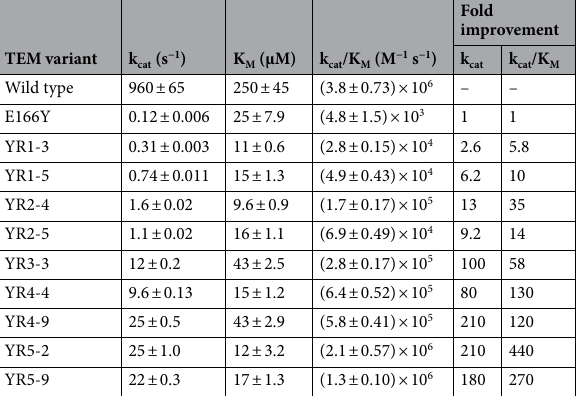
by Mfold 26 (Fig. 2c). The more relaxed regulation of TEM expression in XL1-Blue/pAT- cr3 -TEM was likely to derive from the shortened hairpin structure of cr3 (ΔG cr3 = − 32.90 kcal/mol). Western blot was performed to further examine the levels of wild-type TEM expression in pAT-TEM and pAT- cr3 -TEM. XL1-Blue/pAT-TEM and XL1-Blue/pAT- cr3 -TEM were grown to mid-log phase and induced with different aTc concentrations. The result showed that, in XL1-Blue/pAT-TEM, 25 nM aTc was required to induce aTc-dependent growth phenotype in XL1-Blue/pAT- cr3 -TEM (Fig. 2a). These data suggested that incorporating cr3 to the P